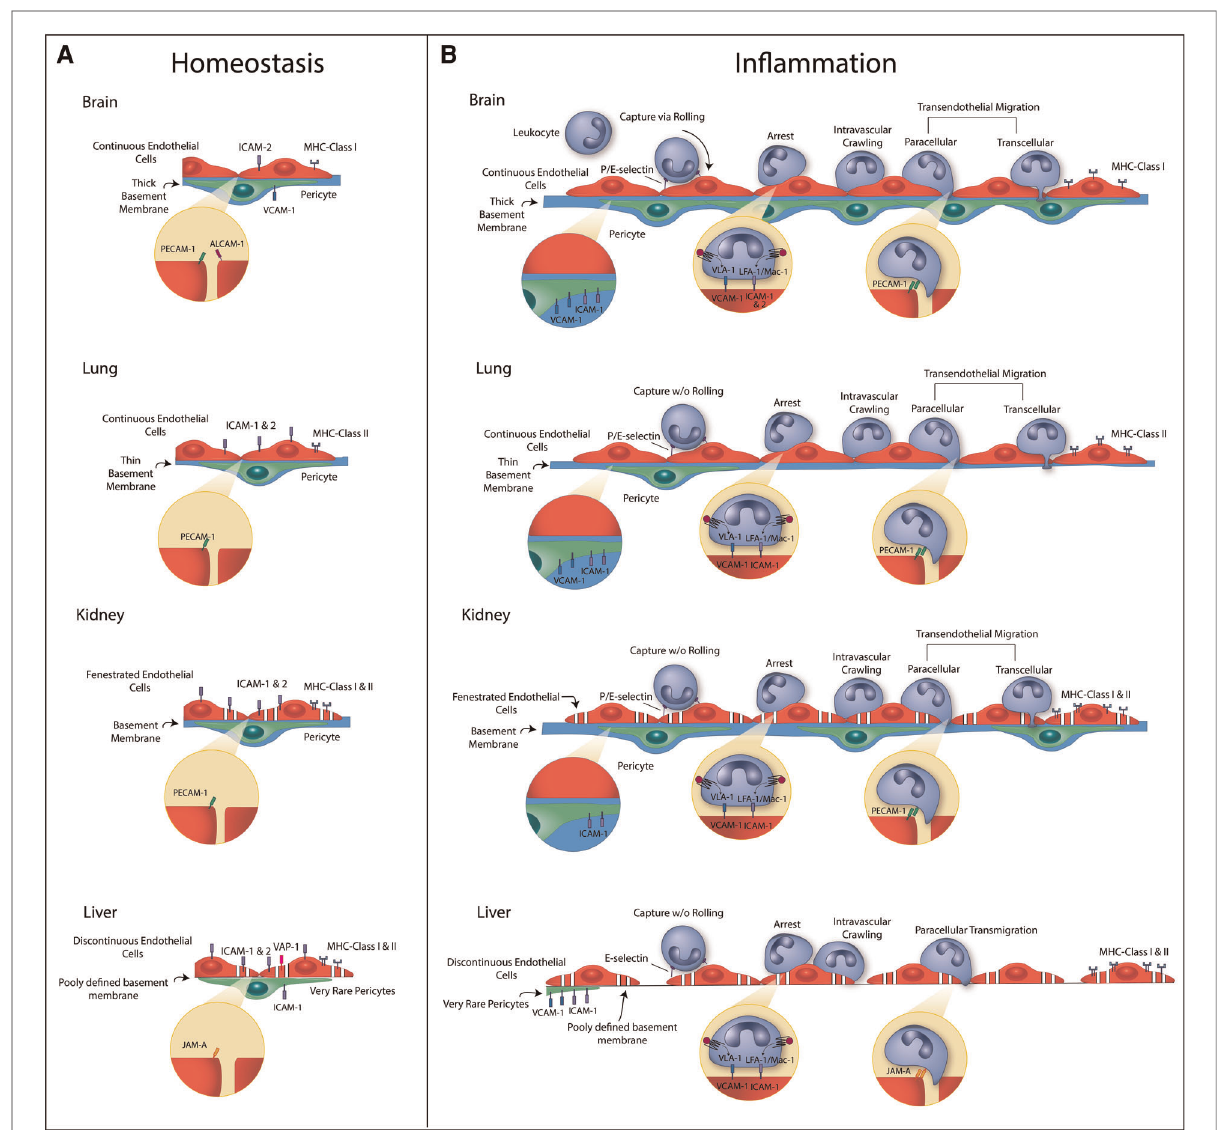
FIGURE 1 Summary of vascular heterogeneity during homeostasis ( A ) and in fl ammation ( B ). Heterogeneity illustrated includes endothelial cell (EC) type, EC to pericyte (PC) ratios, basement membrane (BM) characteristics, and leukocyte adhesion molecule (LAM) and major histocompatibility complex (MHC) expression. Brain: Brain microvessels have continuous ECs with a high EC:PC ratio and thick basement membrane. During homeostasis, there is very low expression of LAMs and MHC molecules. E-selectin and P-selectin are upregulated during in fl ammation and contribute to leukocyte rolling. ICAM-1, ICAM-2, and VCAM-1 are upregulated and contribute to leukocyte arrest and crawling. PECAM-1 at cell junctions assists in leukocyte transmigration (TEM), and ICAM-1 and VCAM-1 are upregulated on PCs to guide leukocytes through the BM into the tissue. MHC Class I molecules can be upregulated, which signal to T cells. Lung : Lung ECs at the air-blood barrier are continuous. There is a relatively low EC:PC ratio and thin basement membrane. During homeostasis, there is low expression of LAMs and MHC molecules. E-selectin and P-selectin can be upregulated during in fl ammation but do not contribute leukocyte rolling. ICAM-1 is upregulated and contributes to leukocyte sequestration and arrest. PECAM-1 at cell junctions assists in leukocyte TEM, and ICAM-1 and VCAM-1 are upregulated on PCs. MHC Class II molecules can be upregulated, which signal to T cells. Kidney: Kidney glomerulus capillaries have fenestrated ECs with a moderate EC:PC ratio and thick basement membrane. During homeostasis, there is constitutive expression of ICAM-1 and ICAM-2 and low expression of MHC molecules. E-selectin can be upregulated during in fl ammation, but leukocyte rolling is debated in the glomerulus. Glomerular ECs rely on platelets for P-selectin. ICAM-1 and VCAM-1 are upregulated and contribute to leukocyte arrest and crawling. PECAM-1 at cell junctions assists in leukocyte TEM, and ICAM-1 is upregulated on PCs to guide leukocytes through the BM into the tissue. MHC Class I and II molecules can be upregulated. Liver: Liver sinusoidal capillaries have discontinuous ECs with a low EC:PC ratio and poorly de fi ned basement membrane. During homeostasis, there is expression of ICAM-1, ICAM-2, VAP-1 and MHC molecules. E-selectin can be upregulated in a subset of ECs during in fl ammation but do not contribute leukocyte rolling. ICAM-1, VCAM-1, and VAP-1 are upregulated and contribute to leukocyte arrest and crawling. JAM-A at cell junctions assists in leukocyte TEM, and ICAM-1 and VCAM-1 are upregulated on PCs. MHC Class II molecules can be